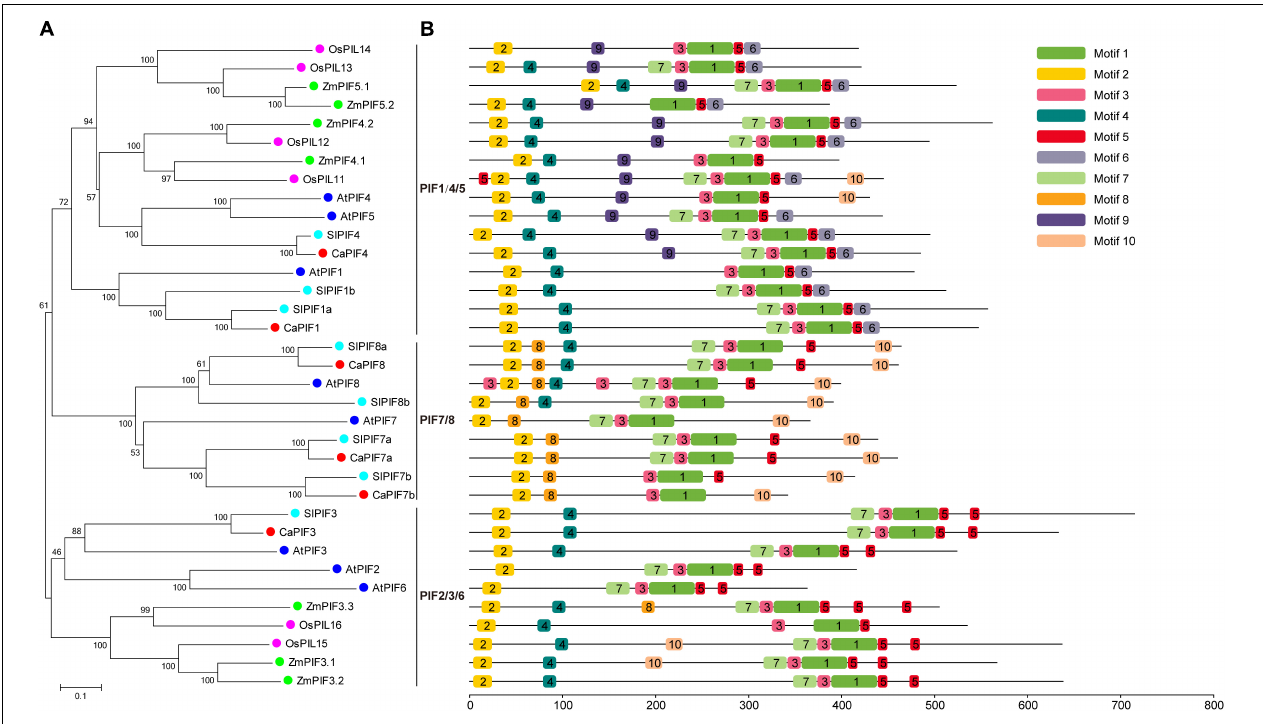
FIGURE 2 | Phylogenetic analysis and conserved motif analysis of the PIF proteins of pepper, Arabidopsis , tomato, rice, and maize. (A) Evolutionary relationships of PIF proteins in pepper, Arabidopsis , tomato, rice, and maize. The phylogenetic tree was created with the neighbor-joining method and 1,000 bootstrap replications conducted in MEGA 7.0. The accession numbers of PIFs used to construct the phylogenetic tree are listed in Supplementary Table 2 . (B) Distribution of the 10 conserved motifs in the PIF proteins of pepper, Arabidopsis , tomato, rice, and maize indicated by the analysis with MEME. Motifs are colored by different boxes and their sequences are listed in Supplementary Table 3